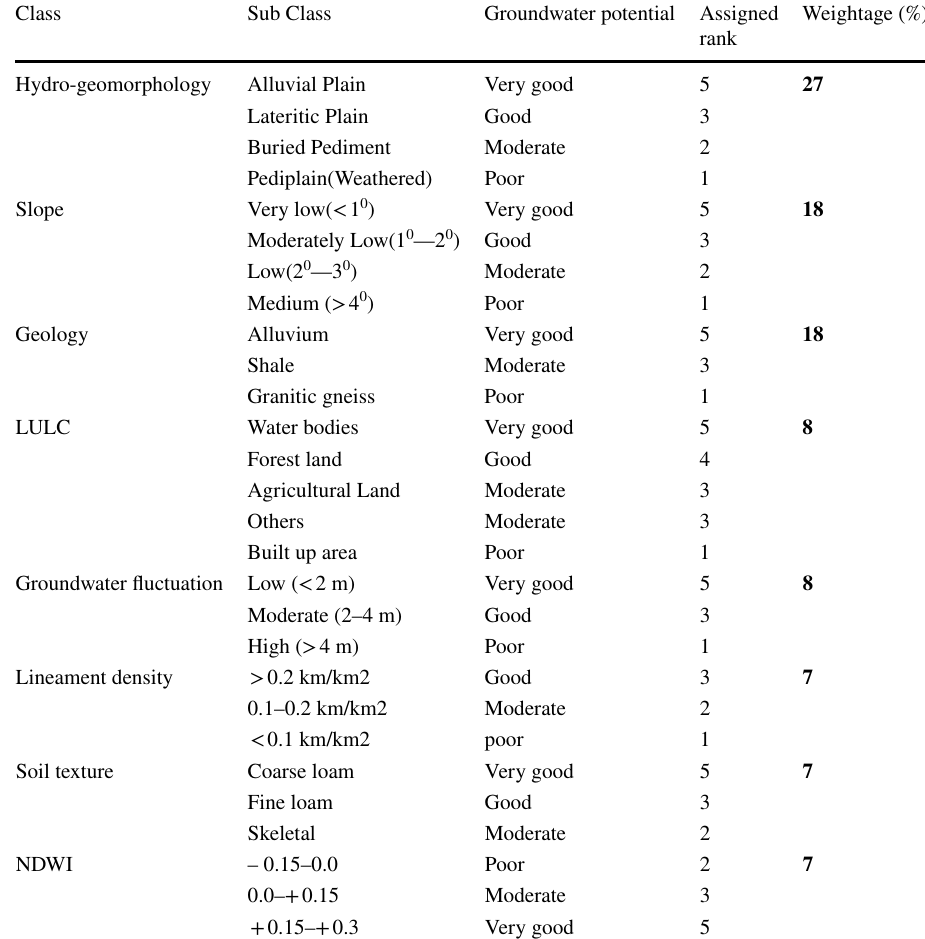
Table 3 Assigned and normalized weights of different features of eight thematic